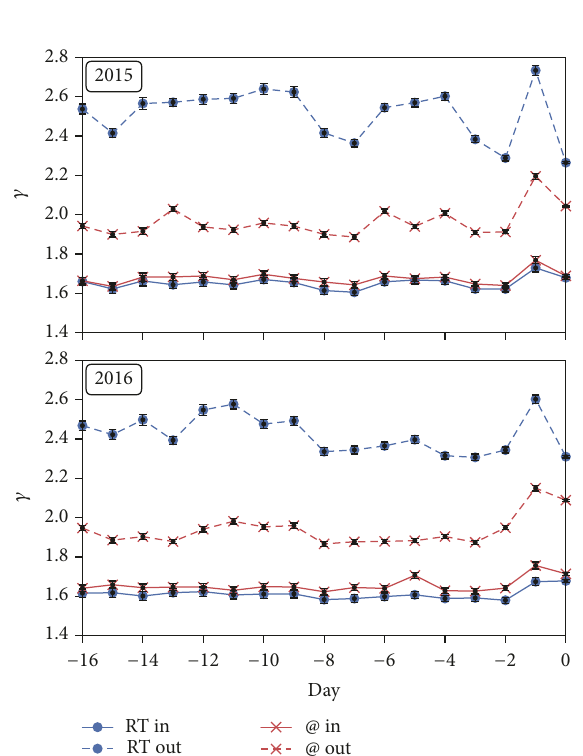
Figure 6: Daily evolution of the 𝛾 exponents of the power law of the in- and out-degree distributions for mentions (@) and retweets (RT) networks for the 2015 (top) and 2016 (bottom) electoral campaigns. 𝛾 2016 = 2.00 ± 0.08 for the mention networks and 𝛾 2015 𝑜𝑢𝑡 = 2.6 ± 0.2 for the retweet networks, 2.7 ± 0.3 and 𝛾 2016 𝑜𝑢𝑡